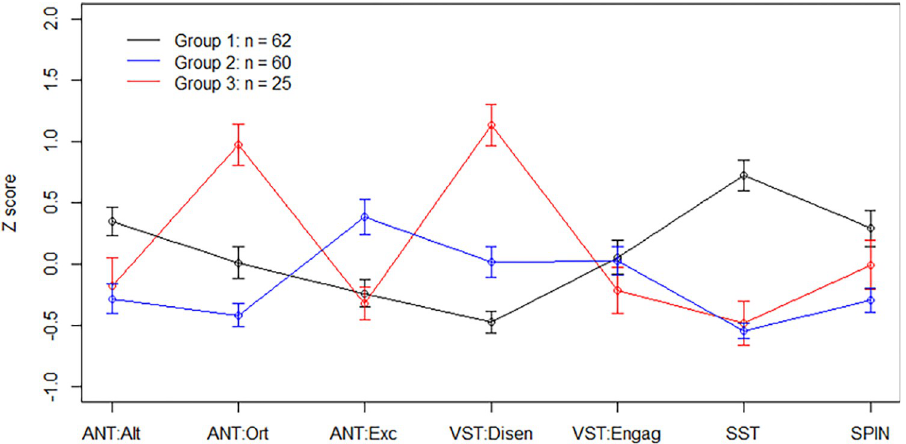
Fig 4. Profiles of cognitive functions identified by hierarchical clustering. ANT: Alt, Ort, Exc = Attention Network Test: Alerting, Orienting, Executive function [higher score indicates better functioning in each domain]. VST: Disen, Engag = Visual search task: disengagement, engagement [higher score indicates greater attention bias]. SST = Scrambled Sentence Task [higher score indicates greater interpretation bias]. SPIN = Social Phobia Inventory [higher score indicates greater symptom severity].